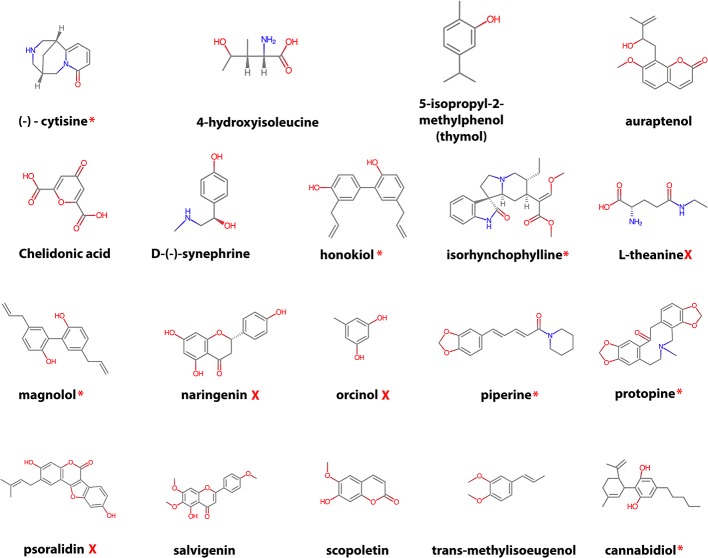
Overview of the selected natural compounds. The red asterisk indicates that previous research found CYP2D6 inhibition (potent to weak) activity for the compound (see Table S1 for the reference), the red cross no CYP2D6 inhibition activity. For the remaining compounds no CYP2D6 inhibition data could be found.